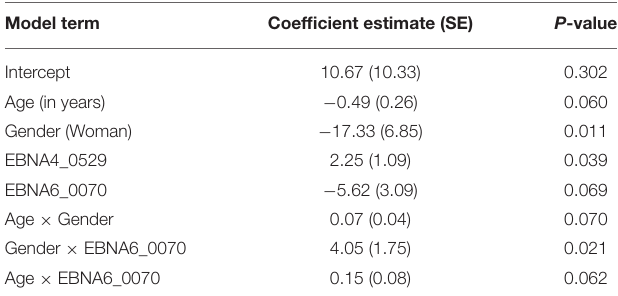
TABLE 2 | Estimates of the final complementary log-log model to discriminate ME/CFS patients with an infectious disease trigger from healthy